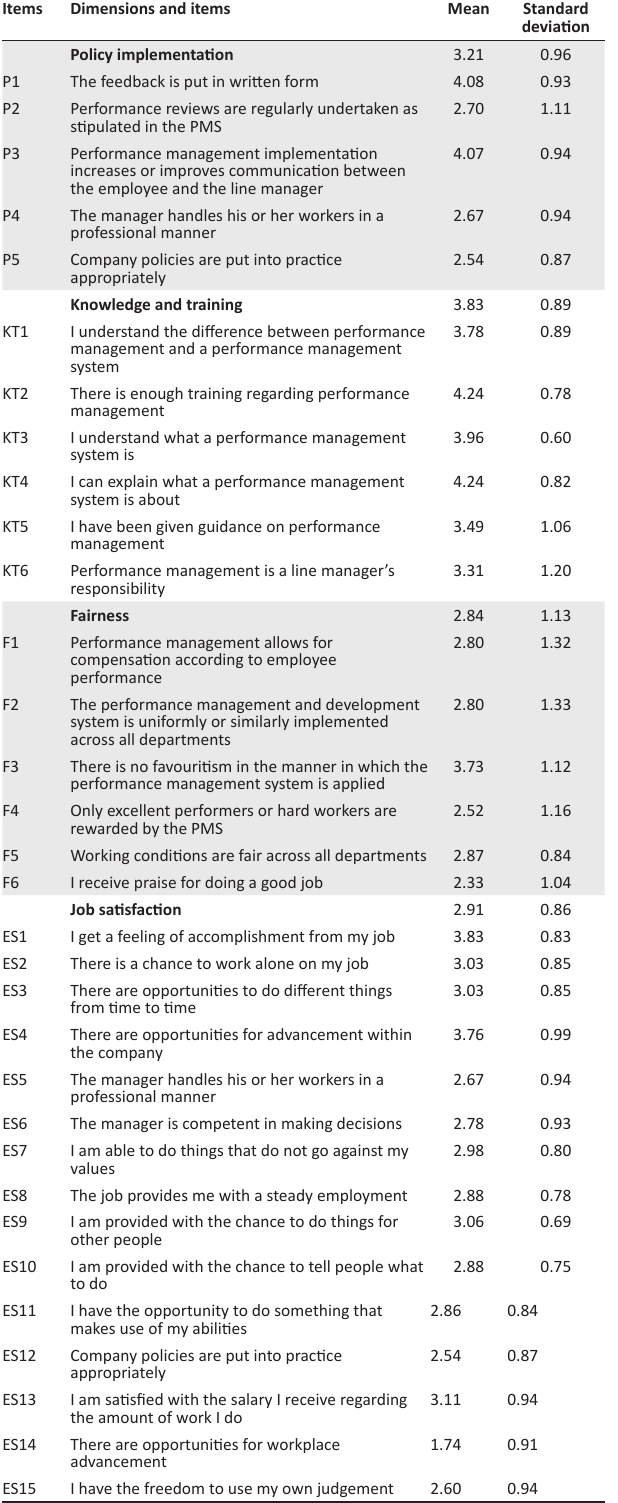
TABLE 3: Mean scores and standard deviations for performance management and job satisfaction ( n = 236).